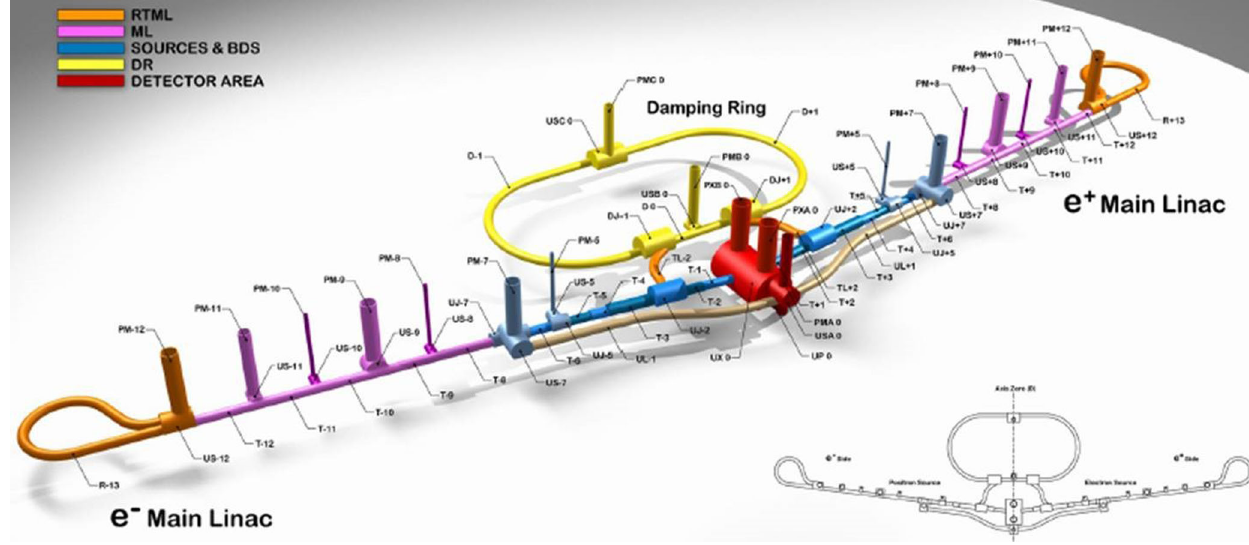
FIG. 1. Schematic layout of the ILC [1].